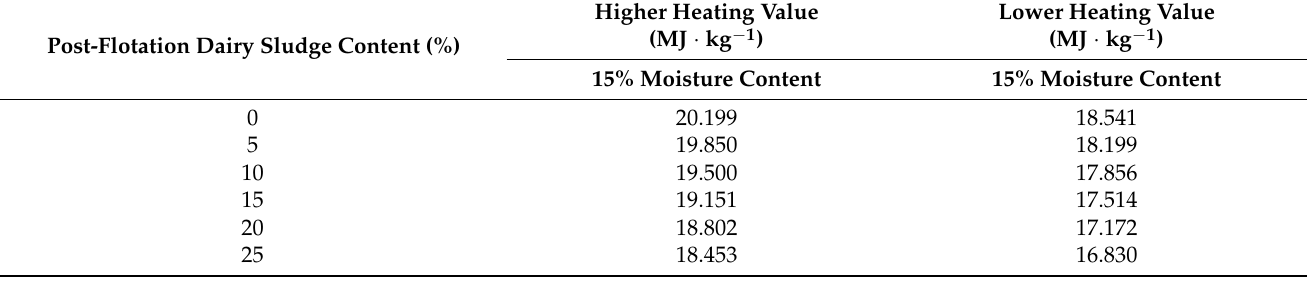
Post-Flotation Dairy Sludge Content (%)